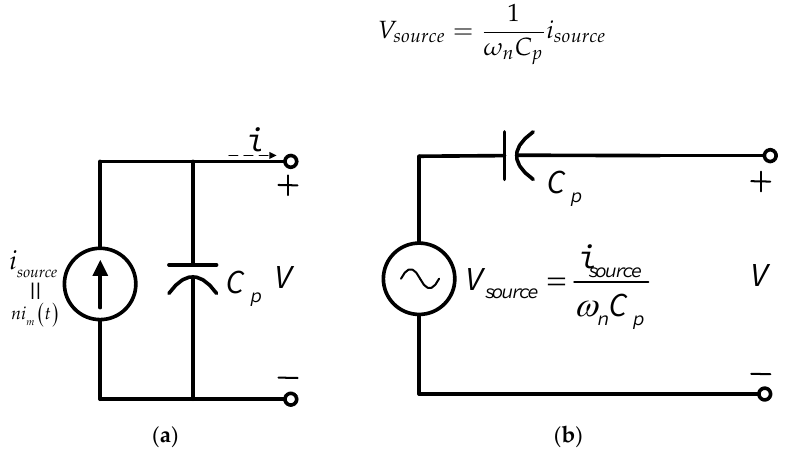
Figure 6. Simplified piezoelectric equivalent circuit form; ( a ) Current source type of Norton ’ s equivalent circuit; ( b ) Voltage source type of Thevenin ’ s equivalent circuit [33].